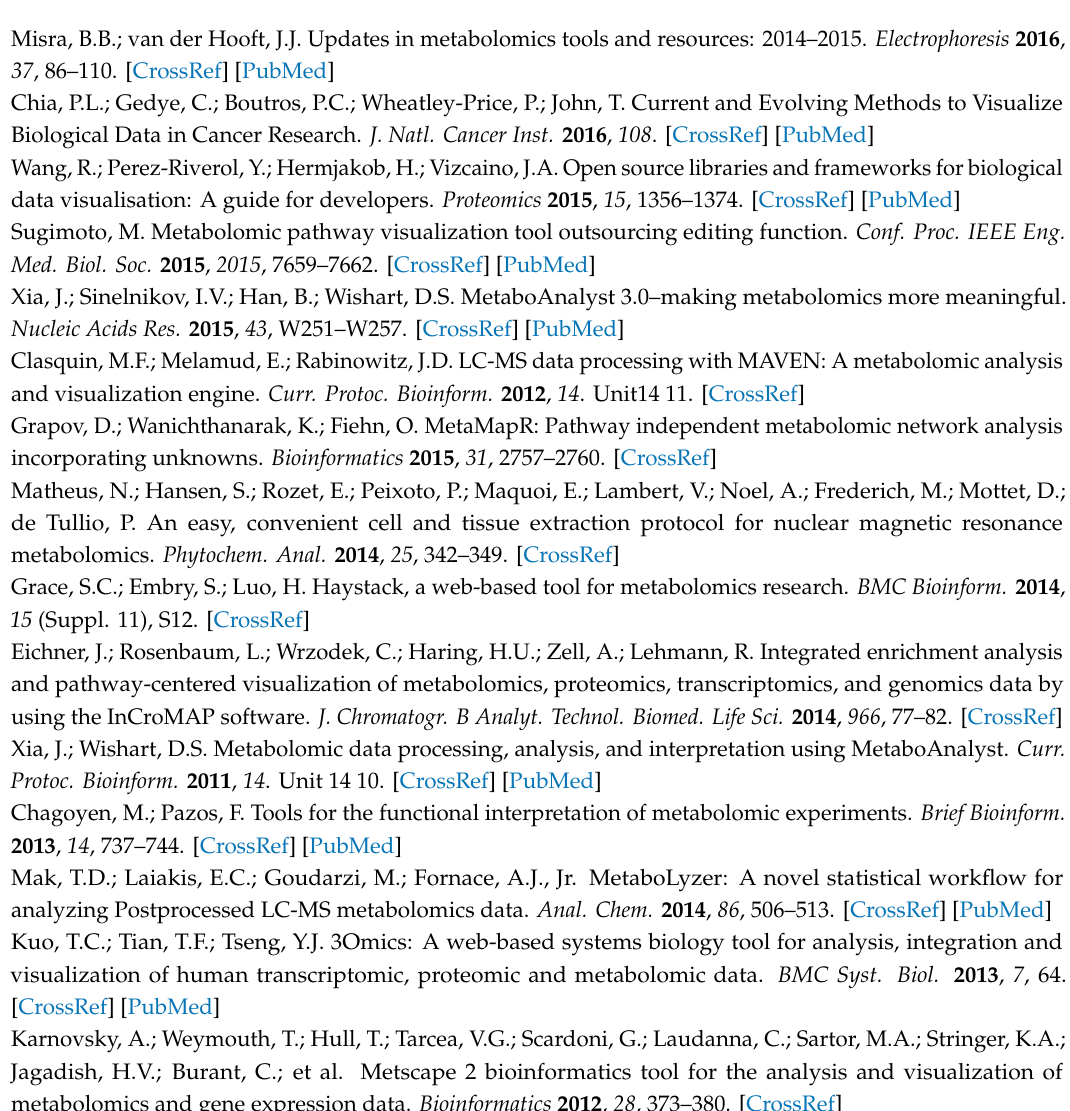
Figure S1: Manhattan plots; Figure S2: Parallel heat maps; Figure S3: Bar and scatter